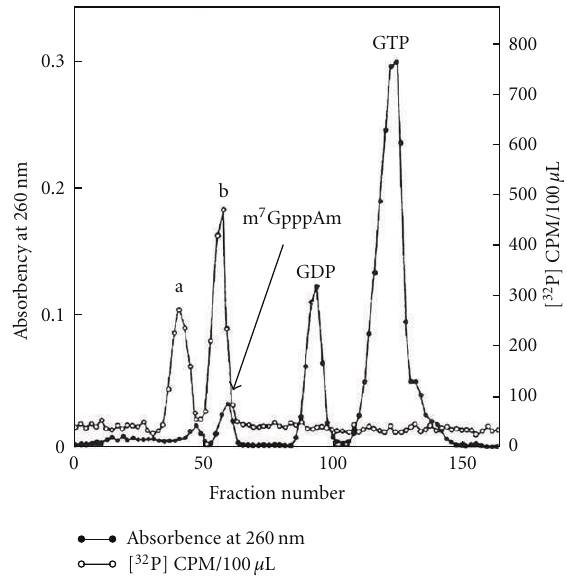
Figure 23: Cap core chromatography [16]. The 5 (cid:2) oligonucleotide eluted from the GTP region (Figure 21) was digested with P1 RNase and chromatographed on a DEAE-Sephadex A-25 column. Two peaks “a” (mononucleotides pUm and pA) and “b” (cap core m 32,2,7 GpppAm) were observed.